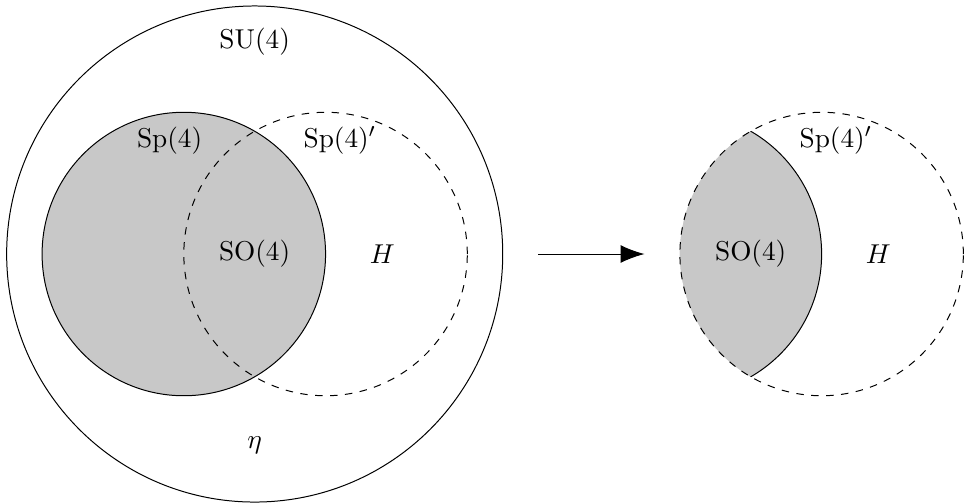
Figure 1 . Symmetry breaking patterns in the disguised SU(4) = Sp(4) model. The solid circles represent the spontaneous breaking in the original model. The dashed circle represents the Sp(4) 0 subgroup preserved by the explicit breaking, so that the ‘disguised’ model becomes Sp(4) 0 =